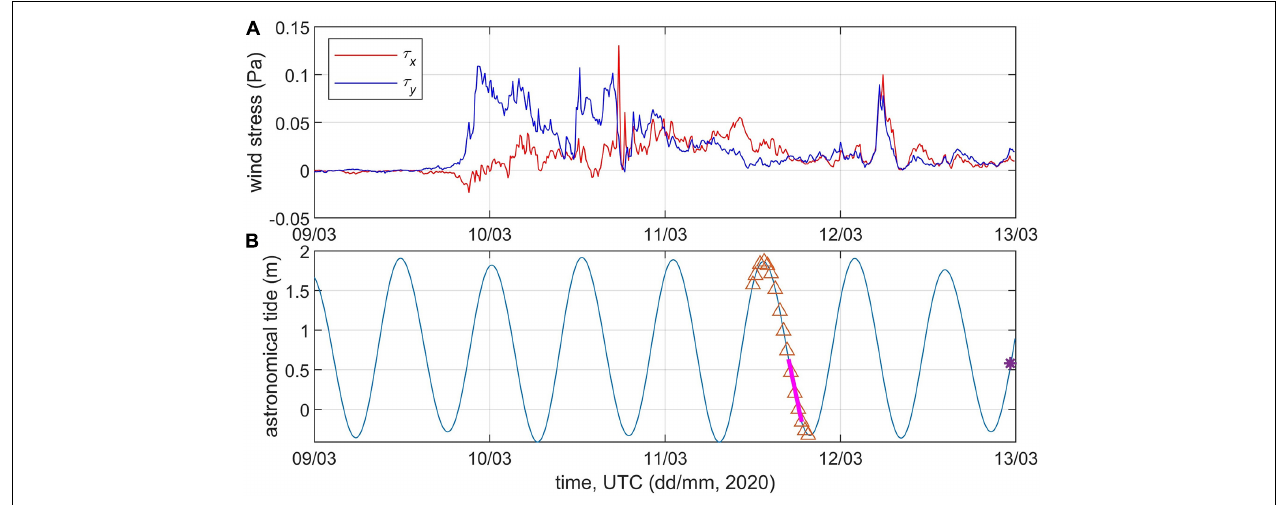
FIGURE 3 | Time series of (A) zonal ( x ) and meridional ( y ) components of the wind stress derived from the NDBC 41013 buoy data; (B) tidal sea level oscillations at Springmaid Pier station. Triangles, heavy magenta line and asterisk represent times for oceanographic stations, data collection for inset image in Figure 2 , and SAR image,